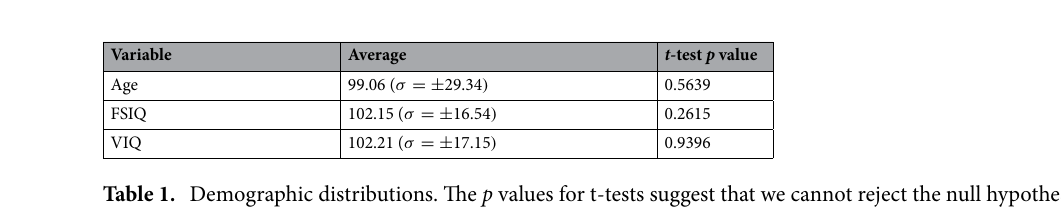
Table 1. Demographic distributions. The p values for t-tests suggest that we cannot reject the null hypothesis that they are from different populations according to these features.